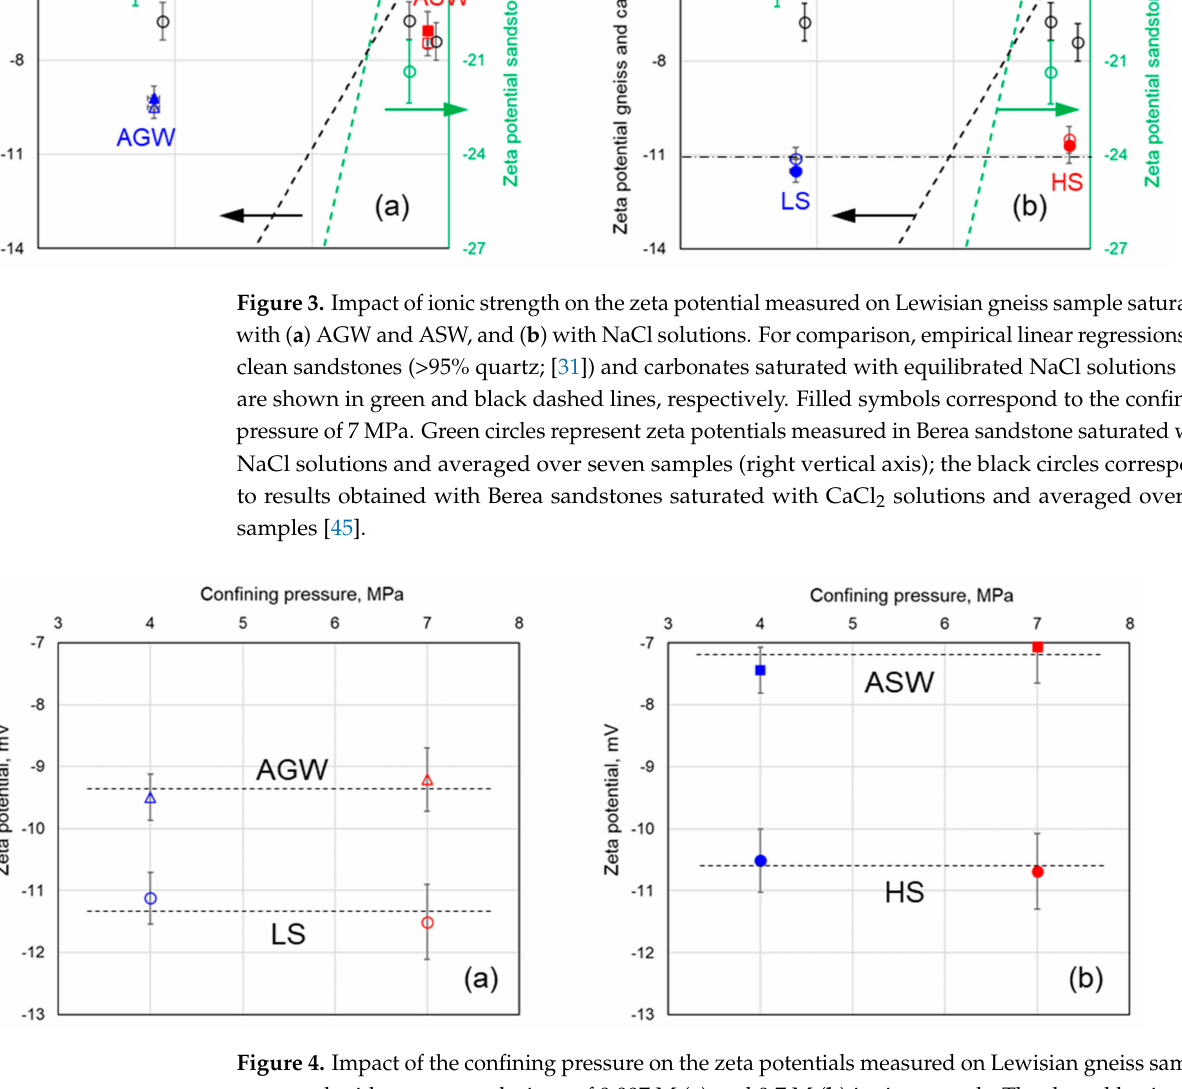
Figure 4. Impact of the confining pressure on the zeta potentials measured on Lewisian gneiss sample saturated with aqueous solutions of 0.007 M ( a ) and 0.7 M ( b ) ionic strength. The dotted horizontal lines demonstrate that the zeta potentials were identical (within the experimental uncertainty) across the salinity